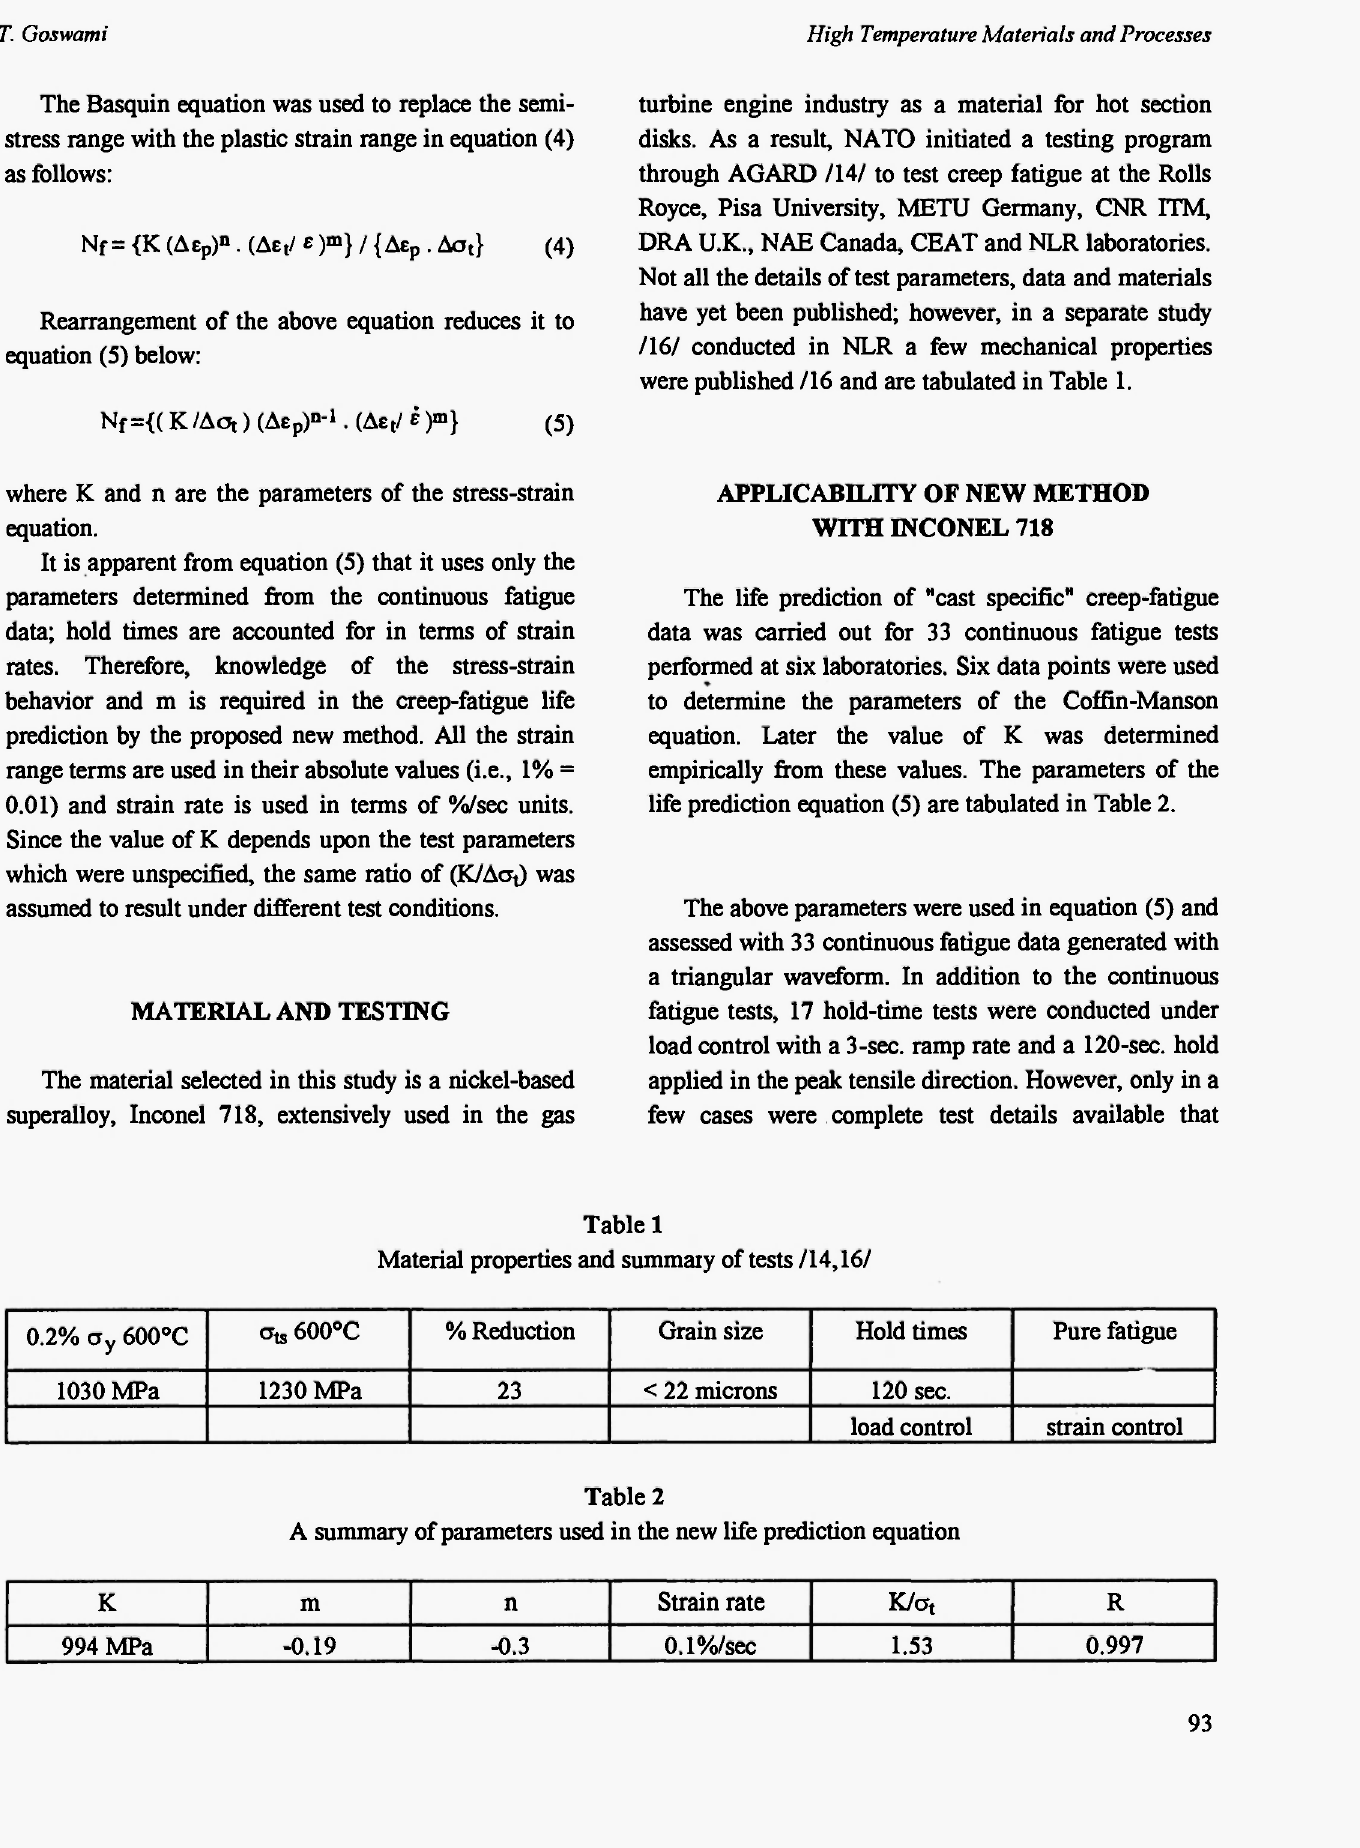
A summary of parameters used in the new life prediction